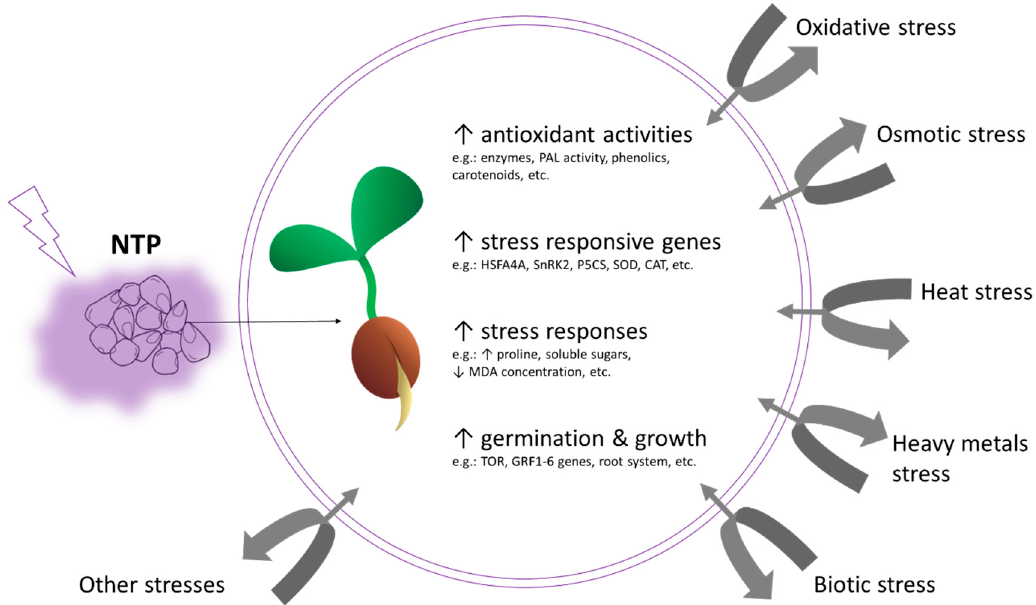
Figure 2. Illustration of some effects of non-thermal plasma on plants. Usually, seeds are treated with NTP. Eventually, the seedling may have an increased activity of antioxidant enzymes or non-enzymatic antioxidants, expression of various genes, usually related to stress response (e.g., heat shock factor HSFA4A or SnRK2 ) or metabolism (e.g., TOR, GRF1-6 ), or increased amounts of e.g., proline or soluble sugars. All these reactions may help a plant tolerate more severe stresses that may occur in the future.